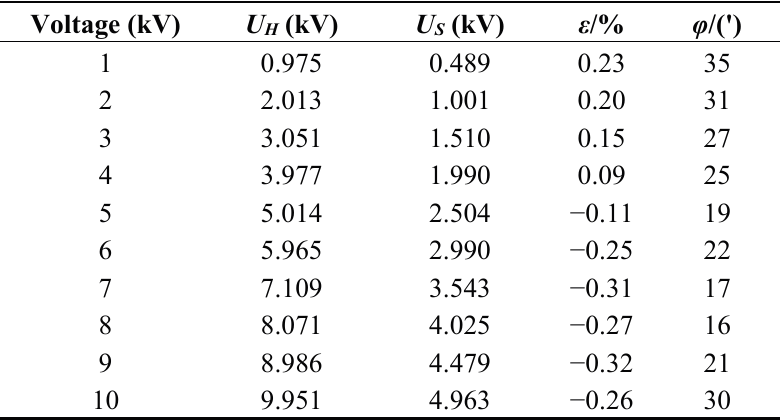
Table 3. Measurement accuracy results of the voltage